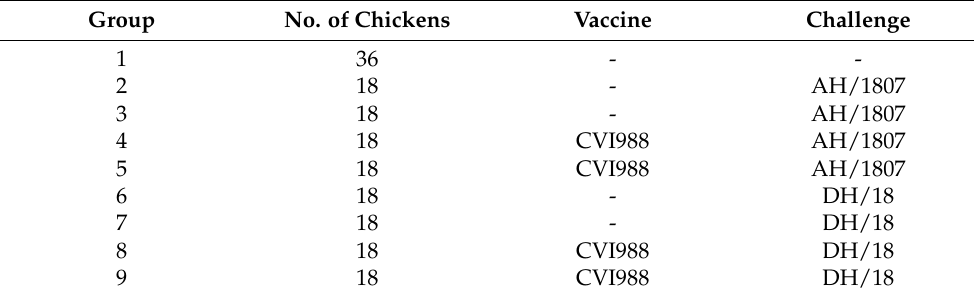
Table 1. Vaccinated and challenged experimental groups used in this study. Group No. of Chickens Vaccine Challenge 1 36 - - 2 18 - AH/1807 3 18 - AH/1807 4 18 CVI988 AH/1807 CVI988 - DH/18 CVI988 DH/18 18 CVI988